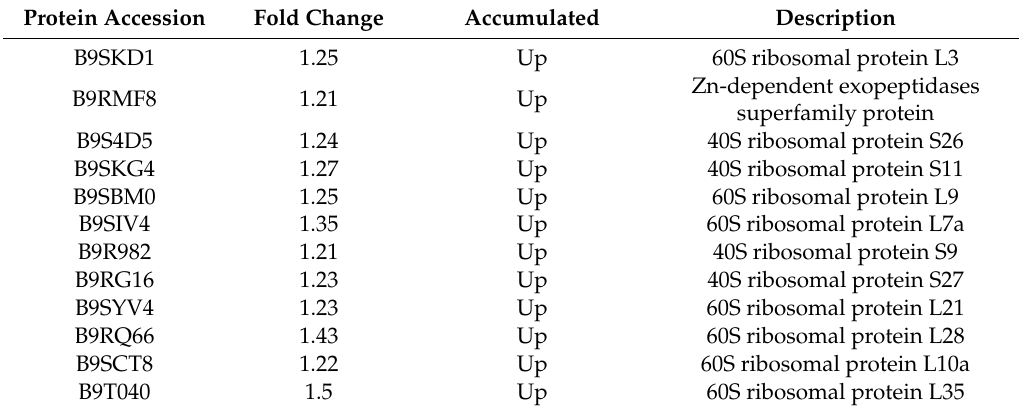
Table 3. Information of DAPS in ribosome